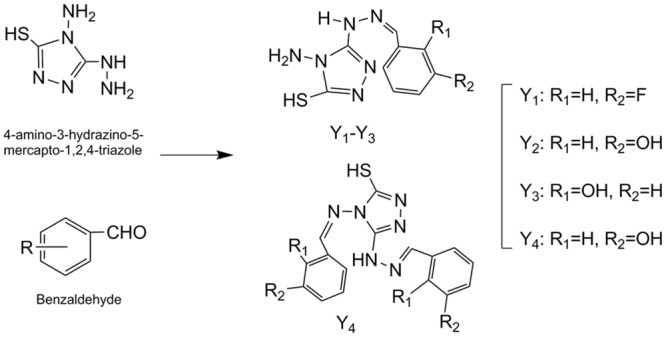
Synthetic processes of compound Y1, Y2, Y3 and Y4.